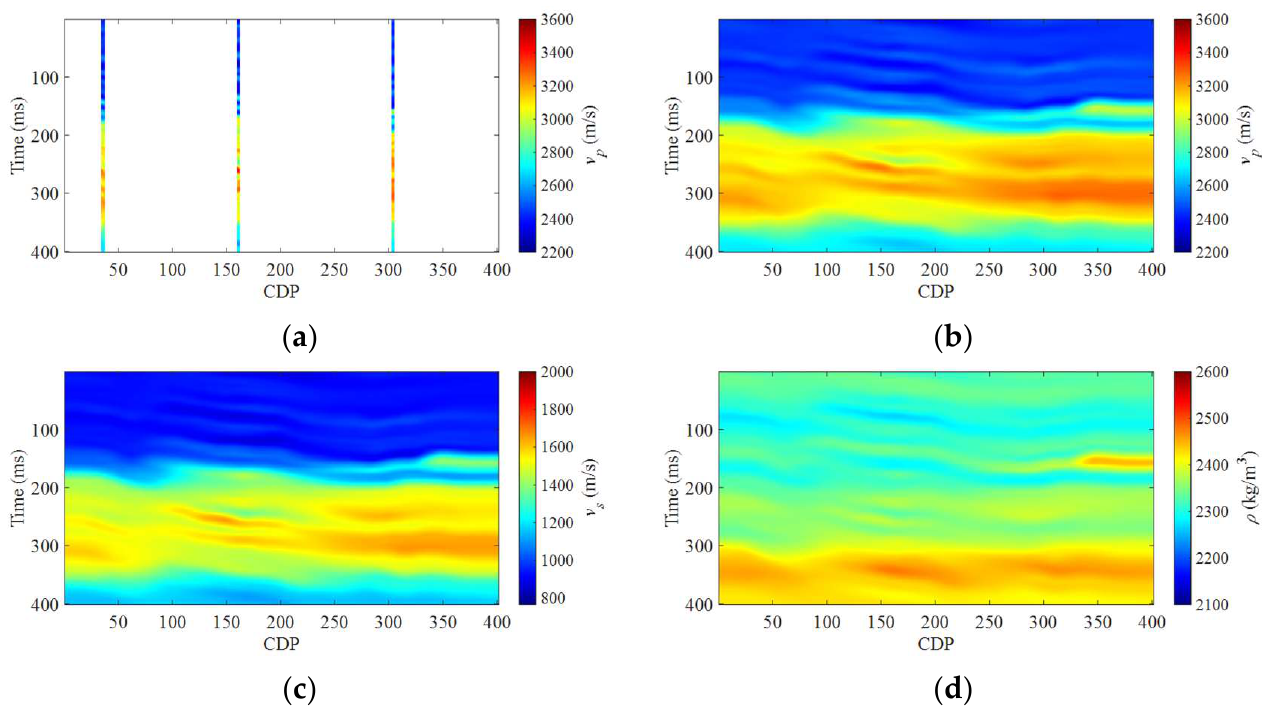
Figure 14. ( a ) The locations of three pseudo-wells and interpolation results of ( b ) v p , ( c ) v s , and ( d ) ρ by FM-NLM.